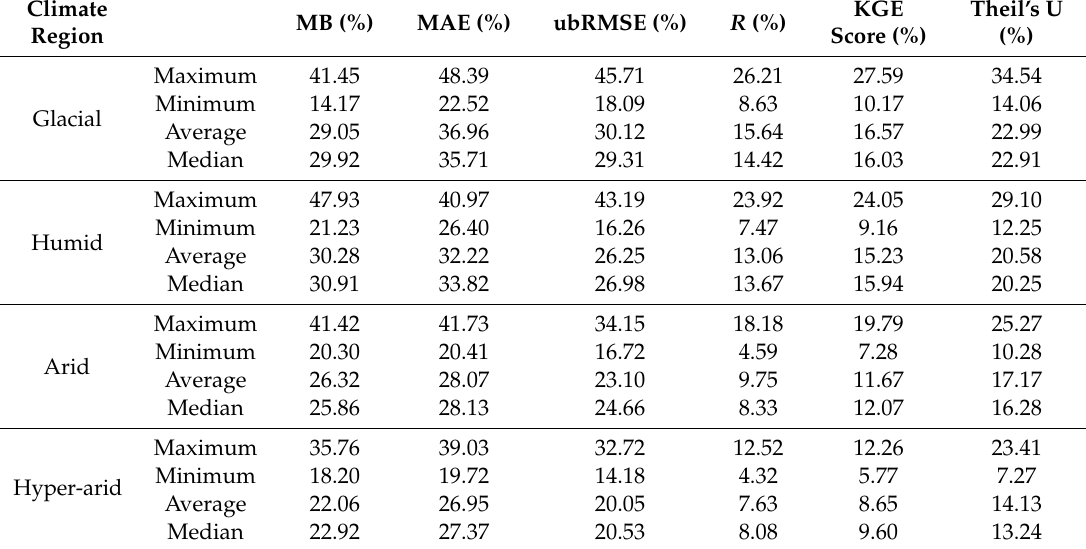
Table 8. Comparison of WALS-RBPD performance with blended precipitation dataset based on dynamic clustered Bayesian model averaging (DCBA-BPD) using skill score during a common period of